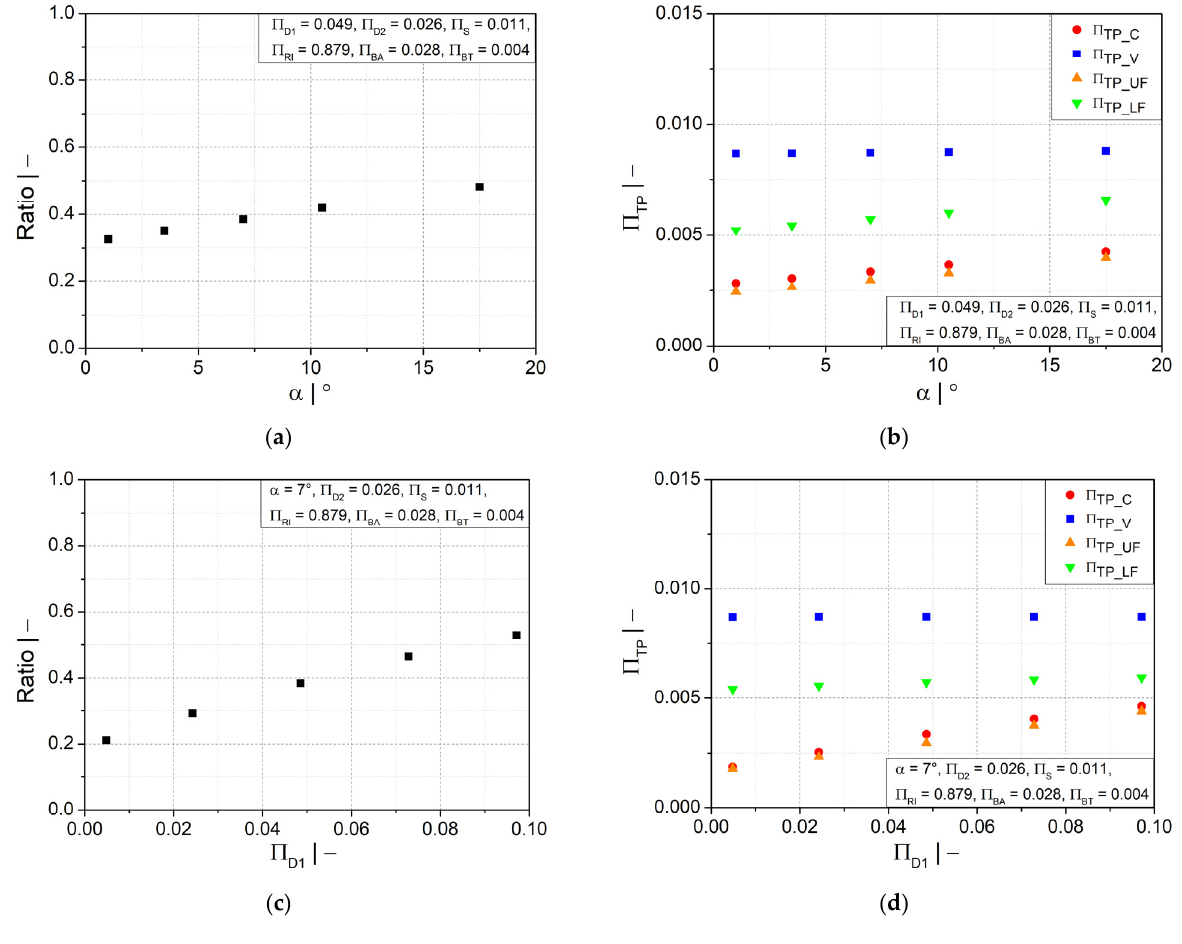
Figure 9. Ratio of wall thicknesses at crest and valley and dimensionless wall thickness as functions of ( a , b ) flank angle α and ( c , d ) dimensionless crest diameter ∏ D